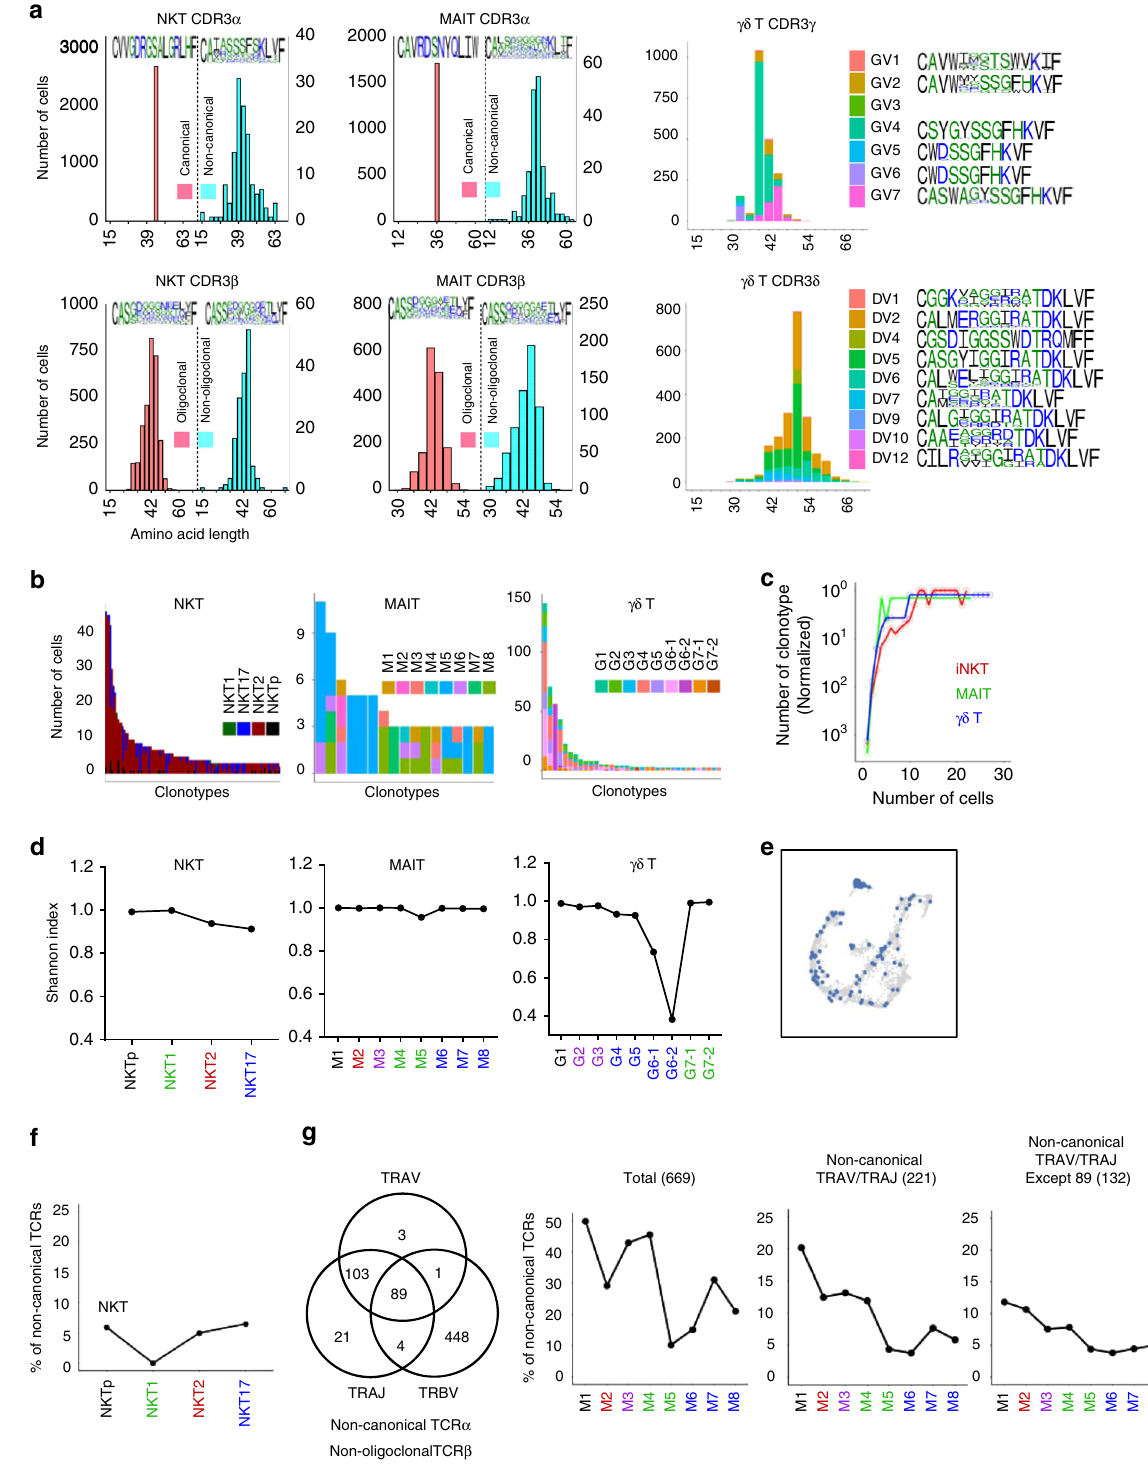
clonotypes of them, which were all NKT2 cells and one of them repeated 15 times, accounting for a total of 18 cells out of 1898 analyzed iNKT clonotypes (Supplementary Table 1 and Supple- mentary data 2). In MAIT cells, 1107 out of 1760 (69%) analyzed clonotypes had canonical TCRs (Supplementary Fig. 9D – E). Interestingly, MAIT cells having one or more non-canonical TCR α and/or non-oligoclonal TCR V β chains were ~50% in M1, but decreased dramatically in MAIT1 (M5, 10%), MAIT2